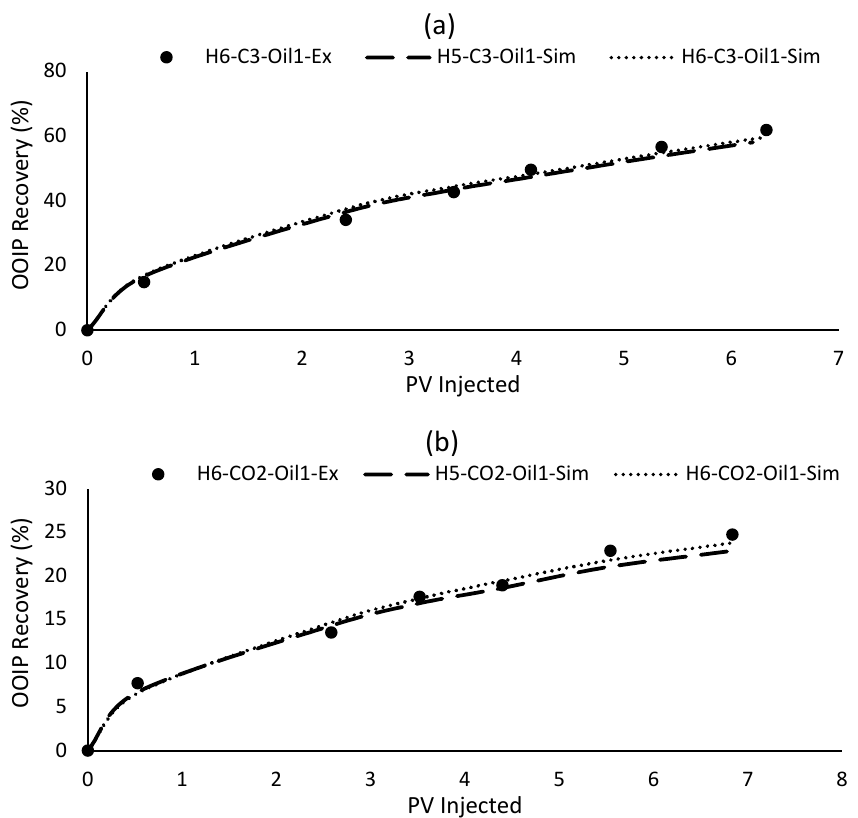
Figure 14. The effect of fracture width on the recovery factors in conventional VAPEX and patterns H5 and H6 using propane ( a ) and carbon dioxide ( b ).